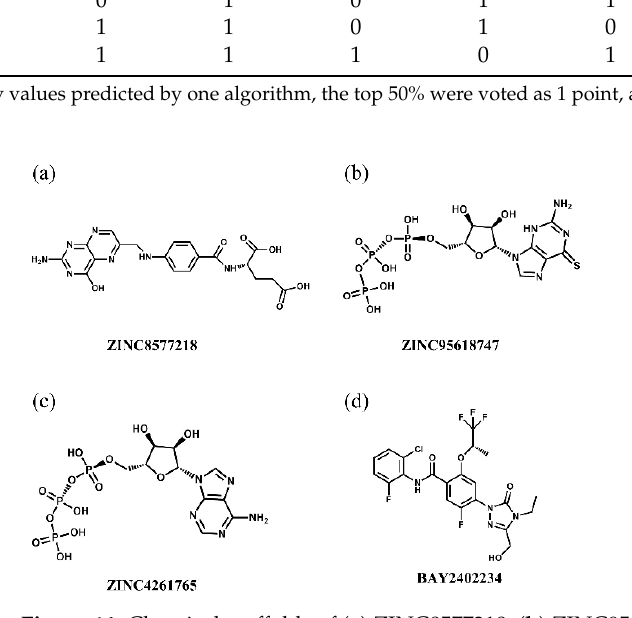
Figure 14. Chemical scaffolds of ( a ) ZINC8577218, ( b ) ZINC95618747, ( c ) ZINC4261765, and ( d ) BAY 2402234.